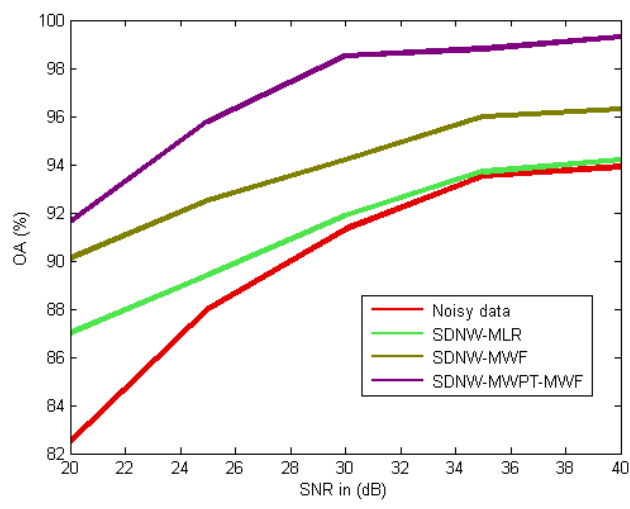
Figure 16. Classification OA with respect to SNR INPUT